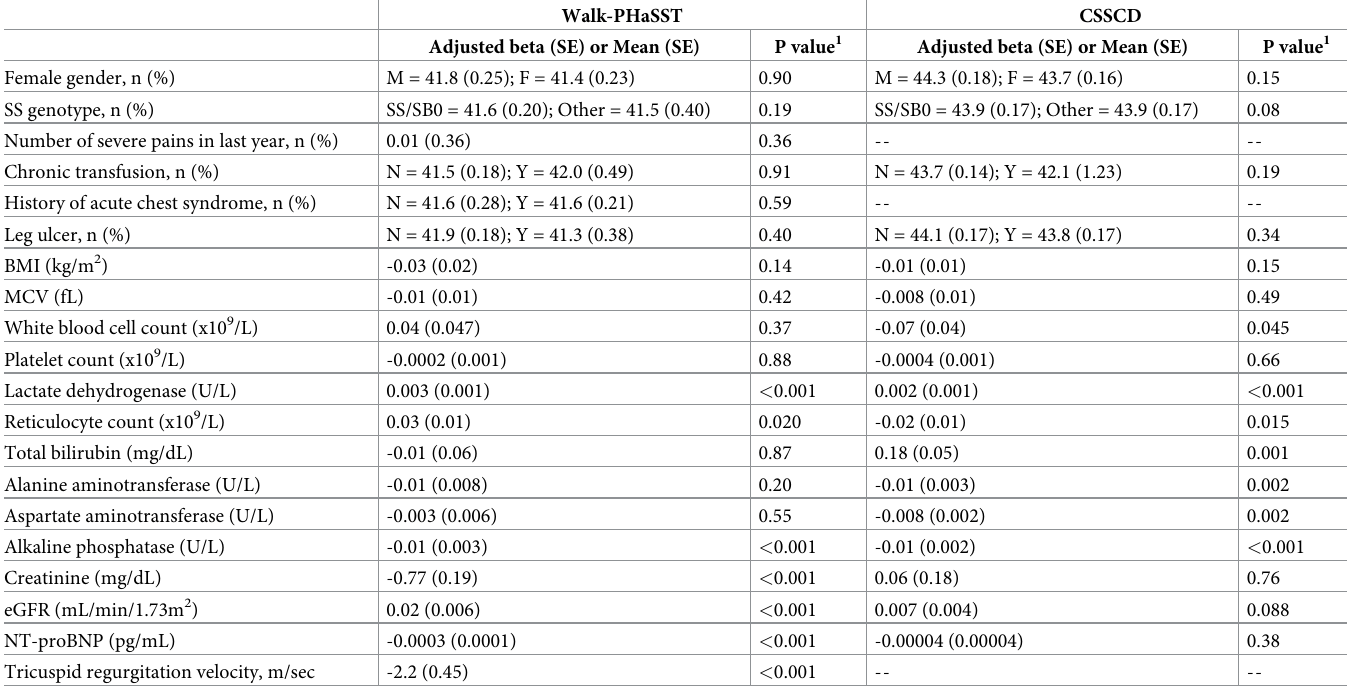
Table 1. Age and hemoglobin adjusted association between serum albumin and sickle cell clinical variables in adults with sickle cell disease in test